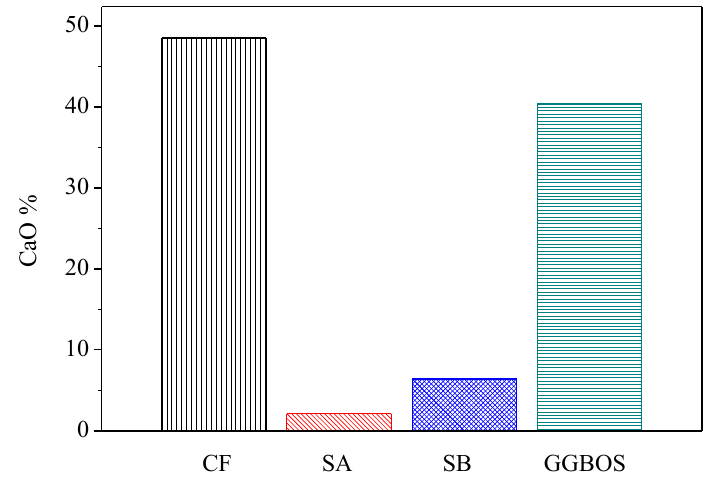
Figure 6. CaO contenting in CF, SA, SB and GGBOS (wt.%). (CF: fly ash of 130 ton/hr. boiler co-firing, SA: fly ash of 65 ton/hr. boiler co-firing, SB: fly ash of 30 ton/hr. boiler co-firing, GGBOS: ground granulated basic oxygen-furnace